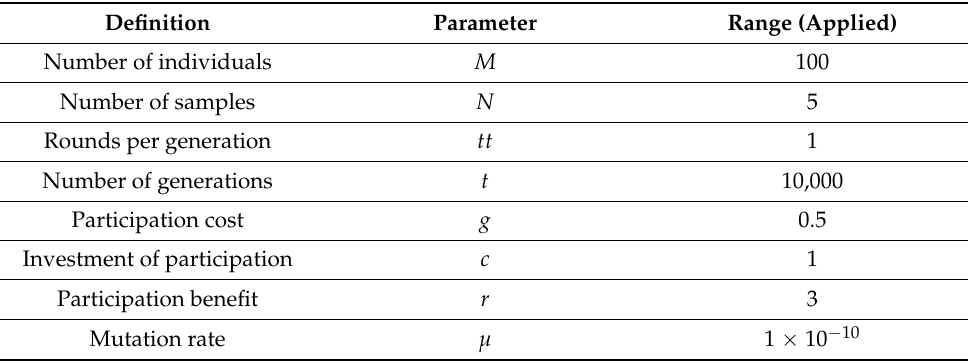
Table 6. Model variables, parameters, and default parameter values.